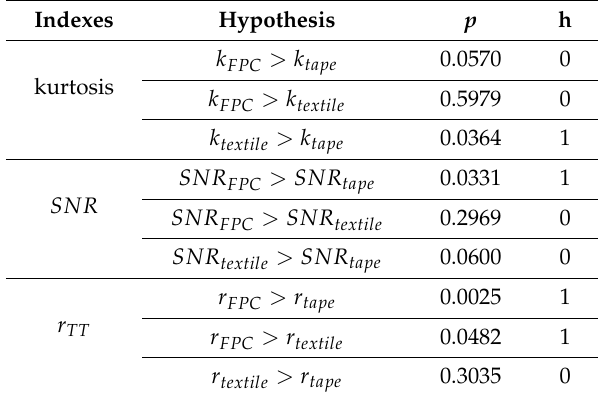
Table 7. Significant t -test of signal quality indexes of three materials (alpha =